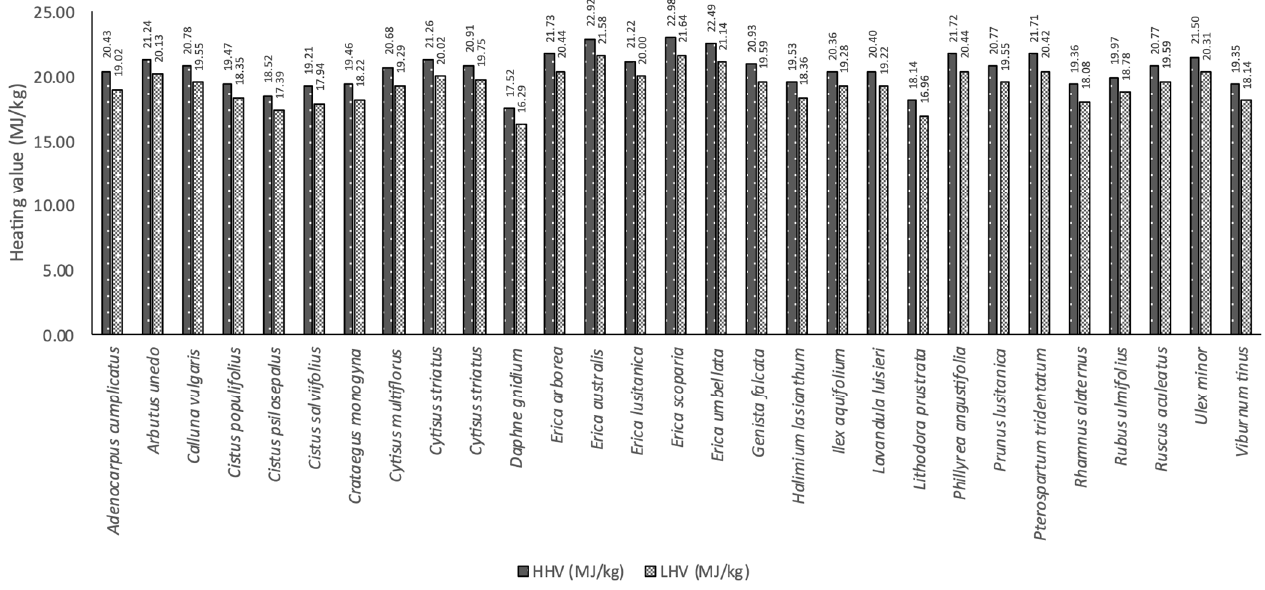
Figure 11. High heating value (HHV) and low heating value